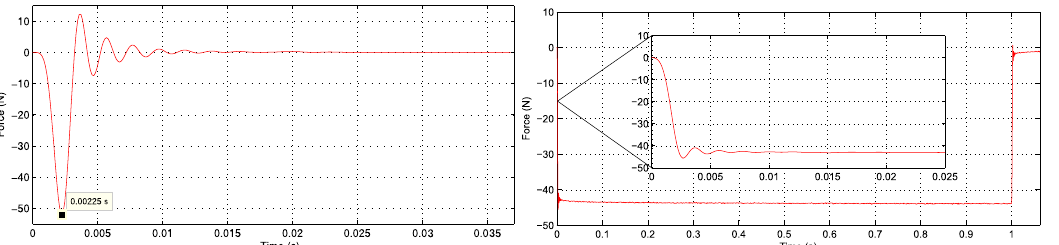
Figure 5. Impulse and step response of JR3 sensor with filter 500 Hz.